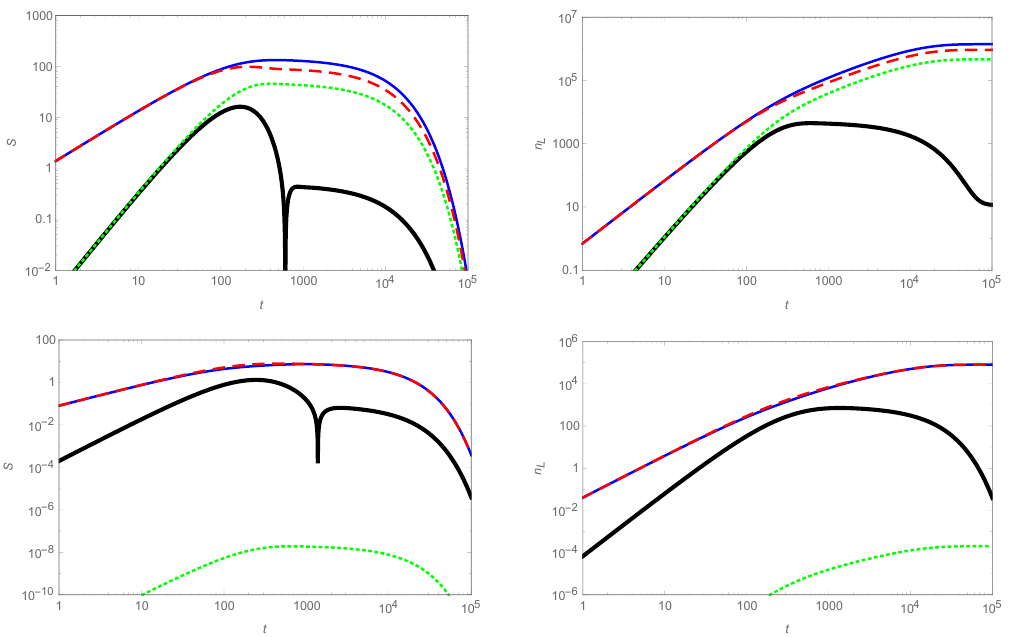
Figure 3 . Same as figure 2 but with another selection of couplings and masses: Γ 1 /M 1 = Γ 2 /M 1 = 1 / 100 and ∆ M = 1 (0 . 01) Γ 1 in the top (bottom) plots. Here we have also taken h 1 = | h 1 | and h 2 = | h 2 | e iφ , with φ = π/ 4 . Therefore in the top plots ˜Γ 1 /M 1 ’ ˜Γ 2 /M 1 ’ 1 / 100 and ∆ ˜ M ’ 0 . 7 ˜Γ 1 , while in the bottom plots ˜Γ 1 /M 1 ’ 0 . 003 , ˜Γ 2 /M 1 ’ 0 . 017 and ∆ ˜ M ’ 2 × 10 − 6 ˜Γ 1